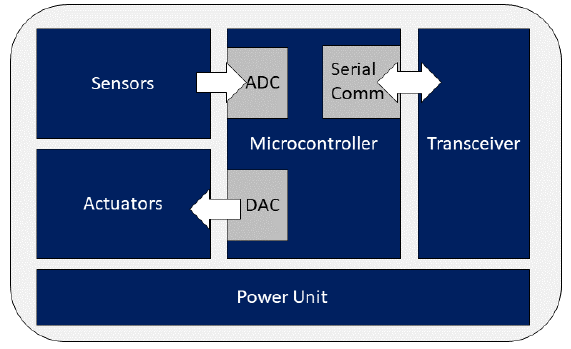
Figure 1. Basic functional elements of an IoT